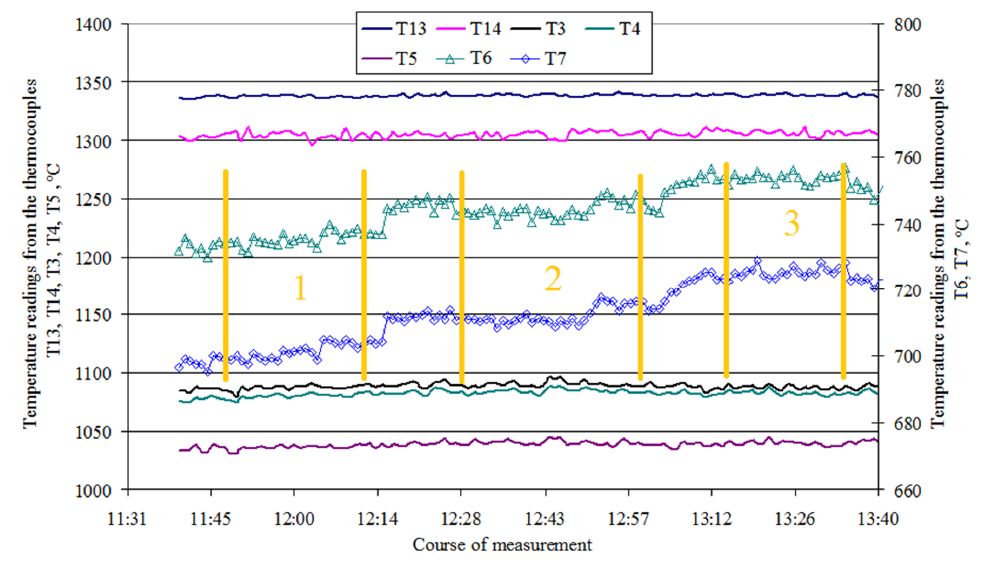
Figure A2. Measured flue-gas temperatures through the furnace during test experiments involving fuel input Q = 1.8 m 3 /h and air excess coefficient m = 1.1 with varying reburning ratio. Stable operation states as indicated in the Figure: 1 = reburning share of 20%; 2 = reburning share of 25%; 3 = reburning share of 35%.